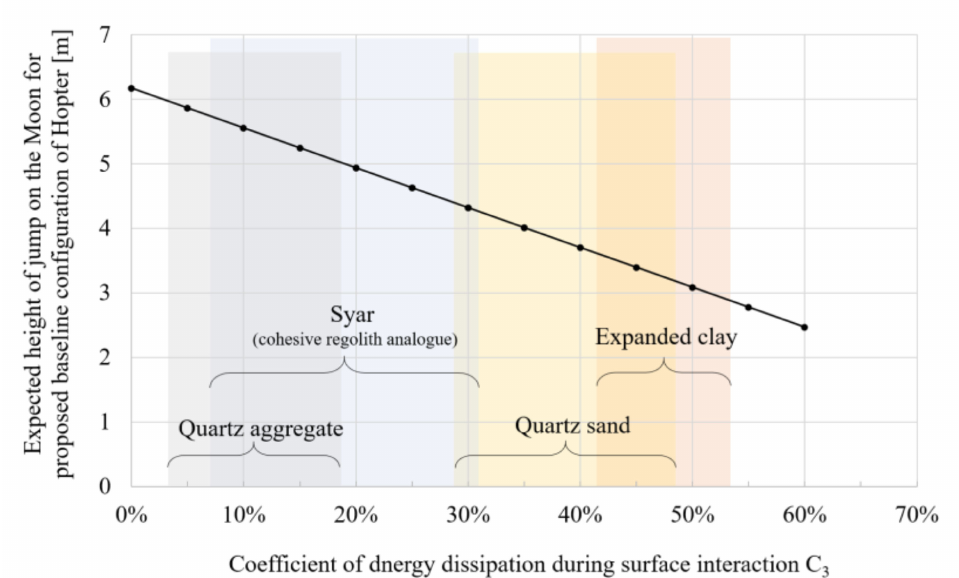
Figure 23. Exemplary maximum height of jump ( h max ) for the 10 kg Hopter in lunar gravity against the measured energy dissipation coefficients (here, for the purpose of the exercise, assuming the coefficient does not change with gravity). The semi-transparent areas are the ones calculated based on the test